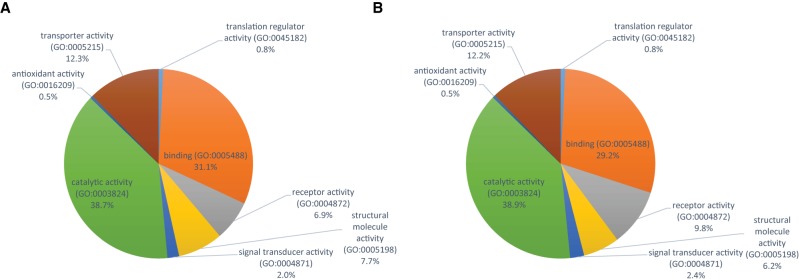
Relative representations of Gene Ontology categories for molecular activities of annotated candidate genes associated with variation in metabolites and module PCs for females (A) and males (B).